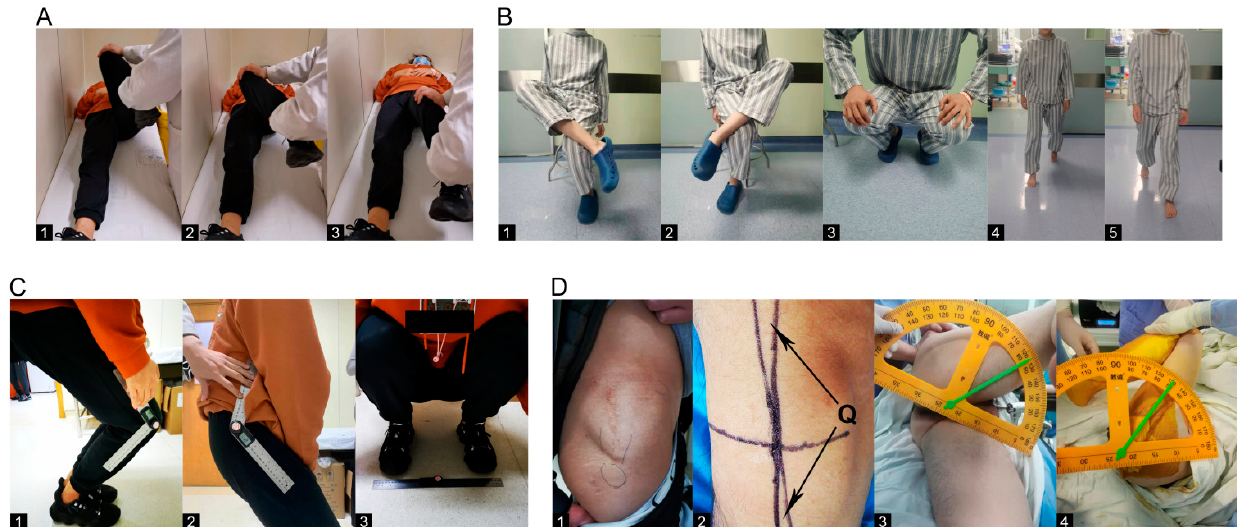
Figure 1. Physical examination of GMC patients. ( A ) In addition to the Ober’s sign, passive induction of hip snapping and hip muscle tightness checks are the most commonly used physical examinations in the clinic. Specifically, the patients lie in a supine or lateral position and ( 1 ) passively flex the hips and knees, ( 2 ) adduct the hip joint and abduct the knee joint, and then ( 3 ) gradually straighten the lower limbs. For patients with severe GMC, obvious snapping can be induced, and the sense of tightness can be felt in the hip. ( B ) ( 1 , 2 ) This patient tested positive for the cross-leg test and was unable to cross his legs; ( 3 ) The patient found it difficult to squat with both knees together, producing frog-like legs; ( 4 , 5 ) Claudication gait, toe-out gait. ( C ) ( 1 , 2 ) Angle of hip flexion and knee flexion when the patient squatted maximally; ( 3 ) Minimum foot distance (Feet distance) required when the patient squatted maximally. ( D ) ( 1 ) Obvious hip contracture band; ( 2 ) Quadriceps angle; ( 3 ) Hip abduction angle in the case of 90° hip flexion and knee flexion under anesthesia; ( 4 ) Maximum angle of hip flexion under anesthesia.